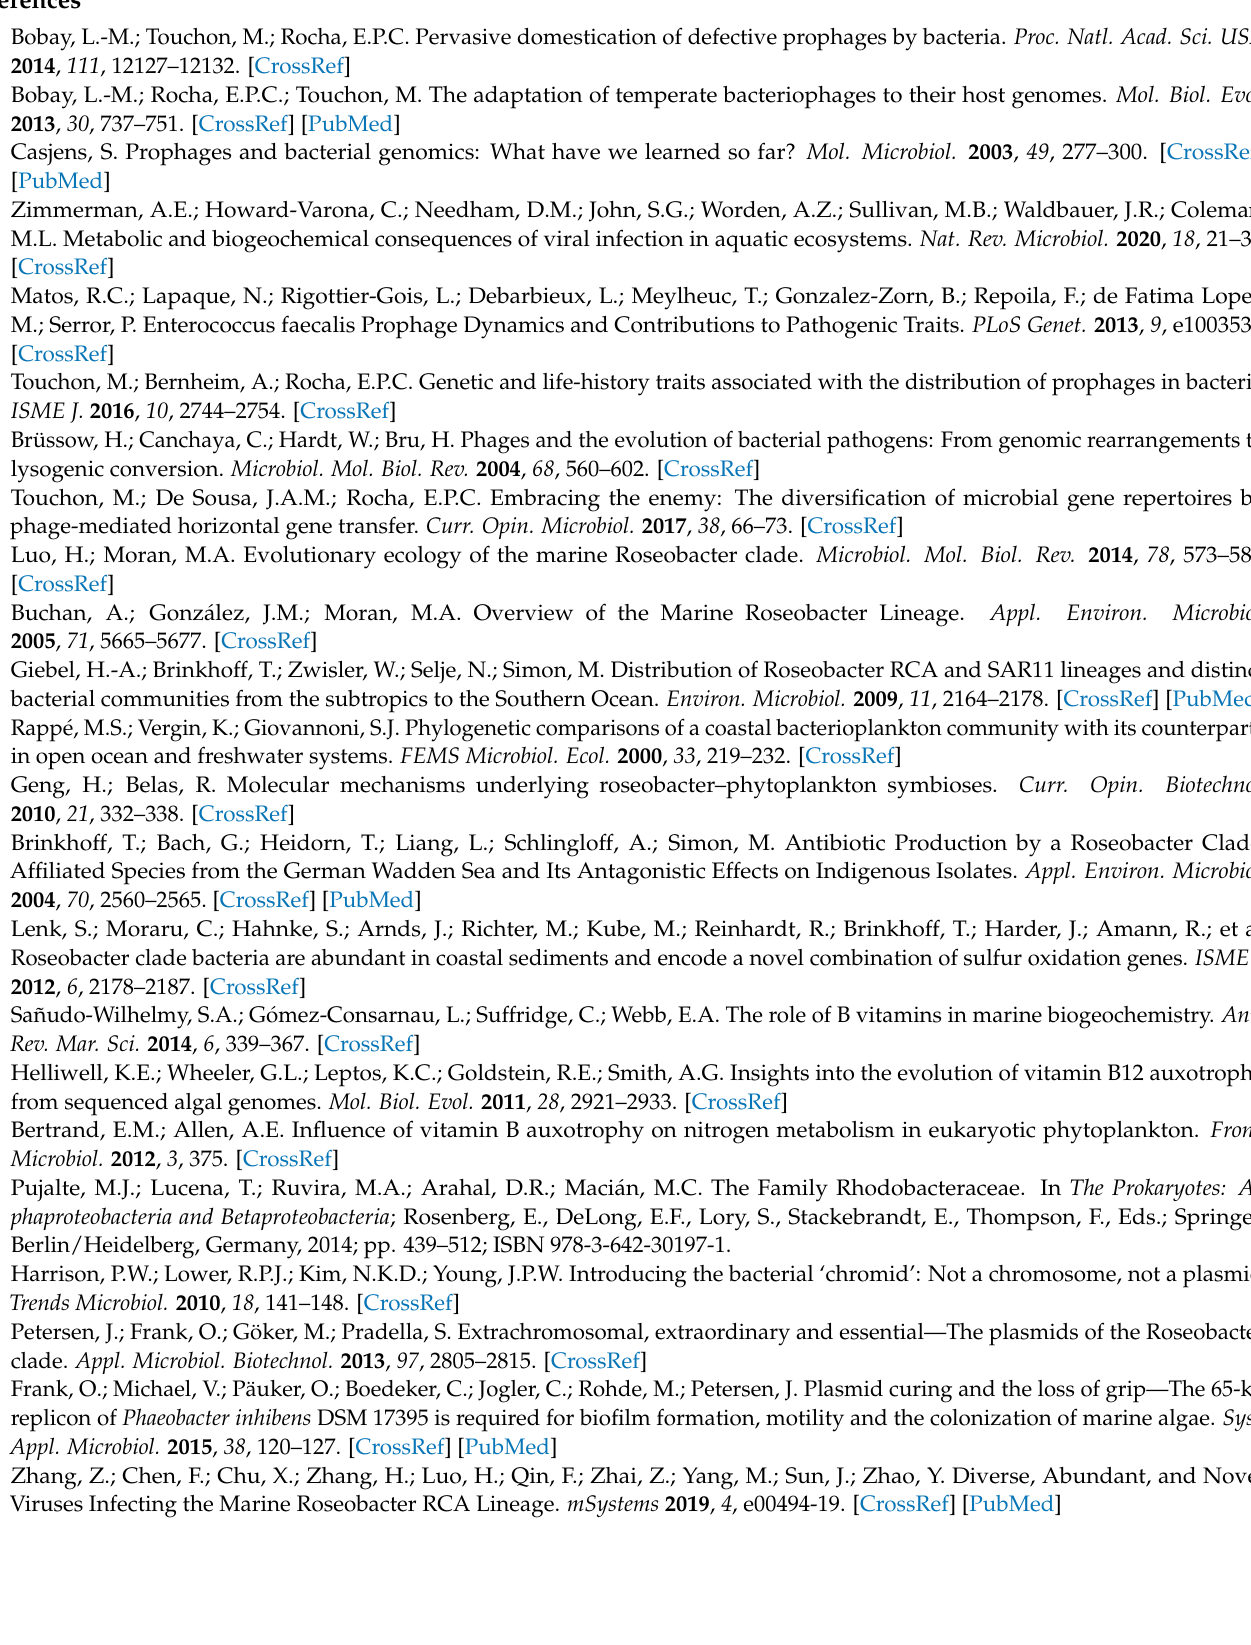
Data Availability Statement: The nucleotide sequences of the predicted prophages are available on FigShare (https://doi.org/10.6084/m9.figshare.14397998.v1) (accessed on 10 April 2021). The NCBI accession numbers of the bacterial genomes analyzed are provided in Table S1. Conflicts of Interest: The authors have no conflict of interest to